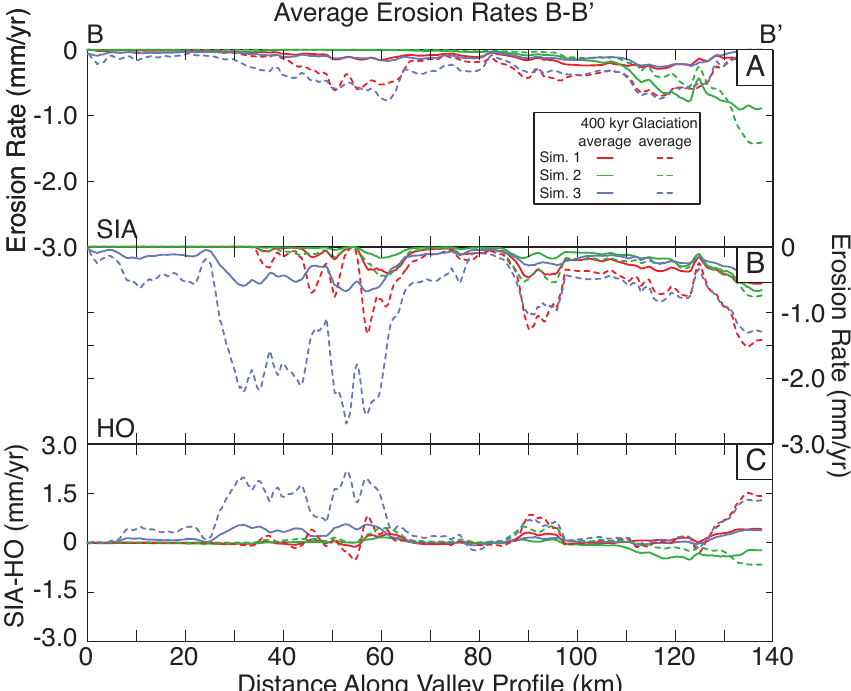
Figure 8. Erosion rates following the B–B’ valley profile (Fig. 1). (a) SIA erosion rates averaged over the 100kyr glaciation (dashed line; grey-shaded areas in Figs. 3 and 4) and over the full simulation (solid line). (b) HO erosion rates averaged over the 100kyr glaciation (dashed line) and over the full simulation (solid line). (c) Difference between the time-averaged erosion rates